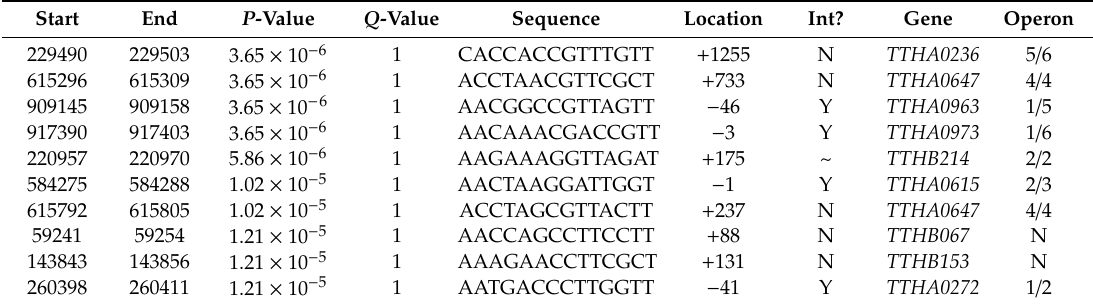
Table 2. FIMO of the best possible matches to the TTHA0973 consensus sequence.